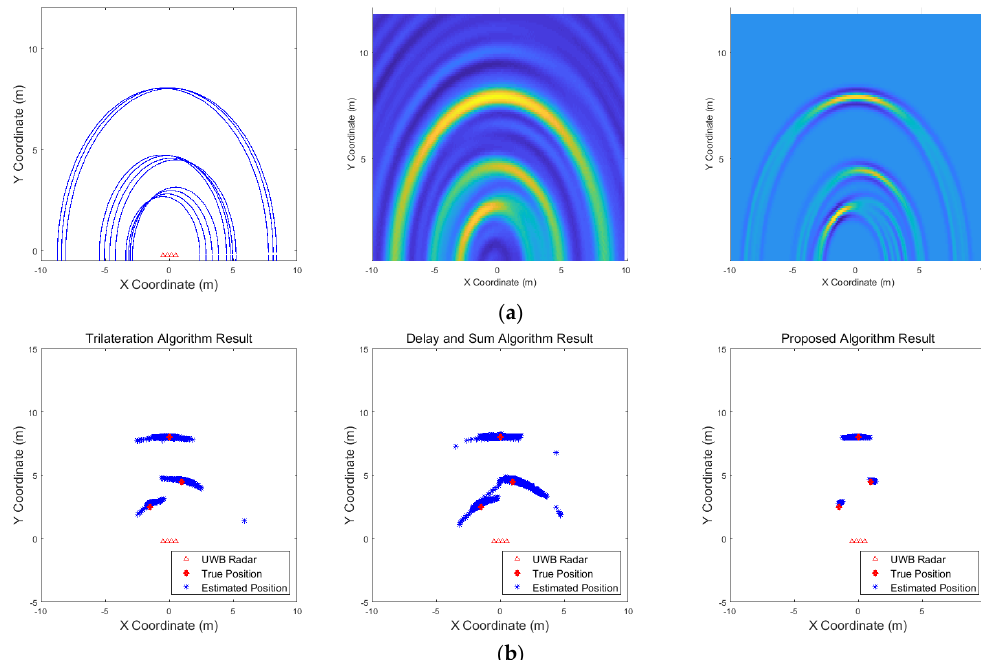
Figure 10. Simulation results when three targets stand (Scenario 2): ( a ) instantaneous results of position estimation step according to the positioning algorithm; ( b ) results of the radar system for the entire simulation